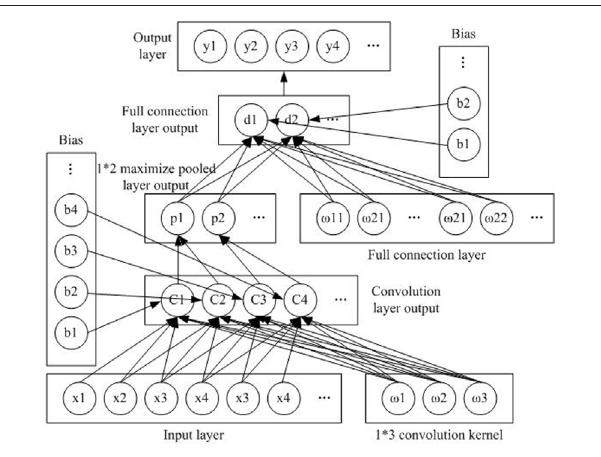
FIGURE 2 | Convolutional neural